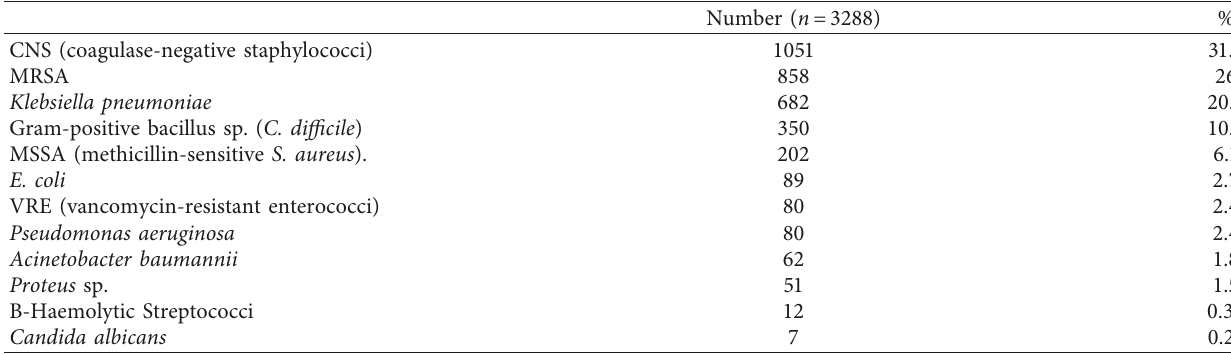
Table 3: Type of isolated organisms from different hospitals (2009–2015) in Assiut city.